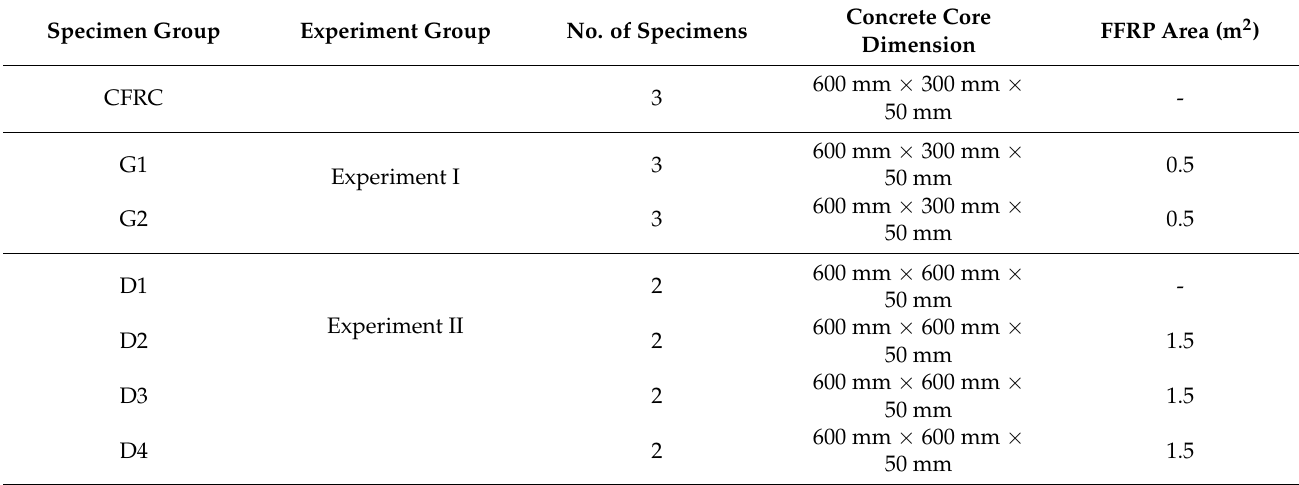
Table 3. Test matrix of the specimens.